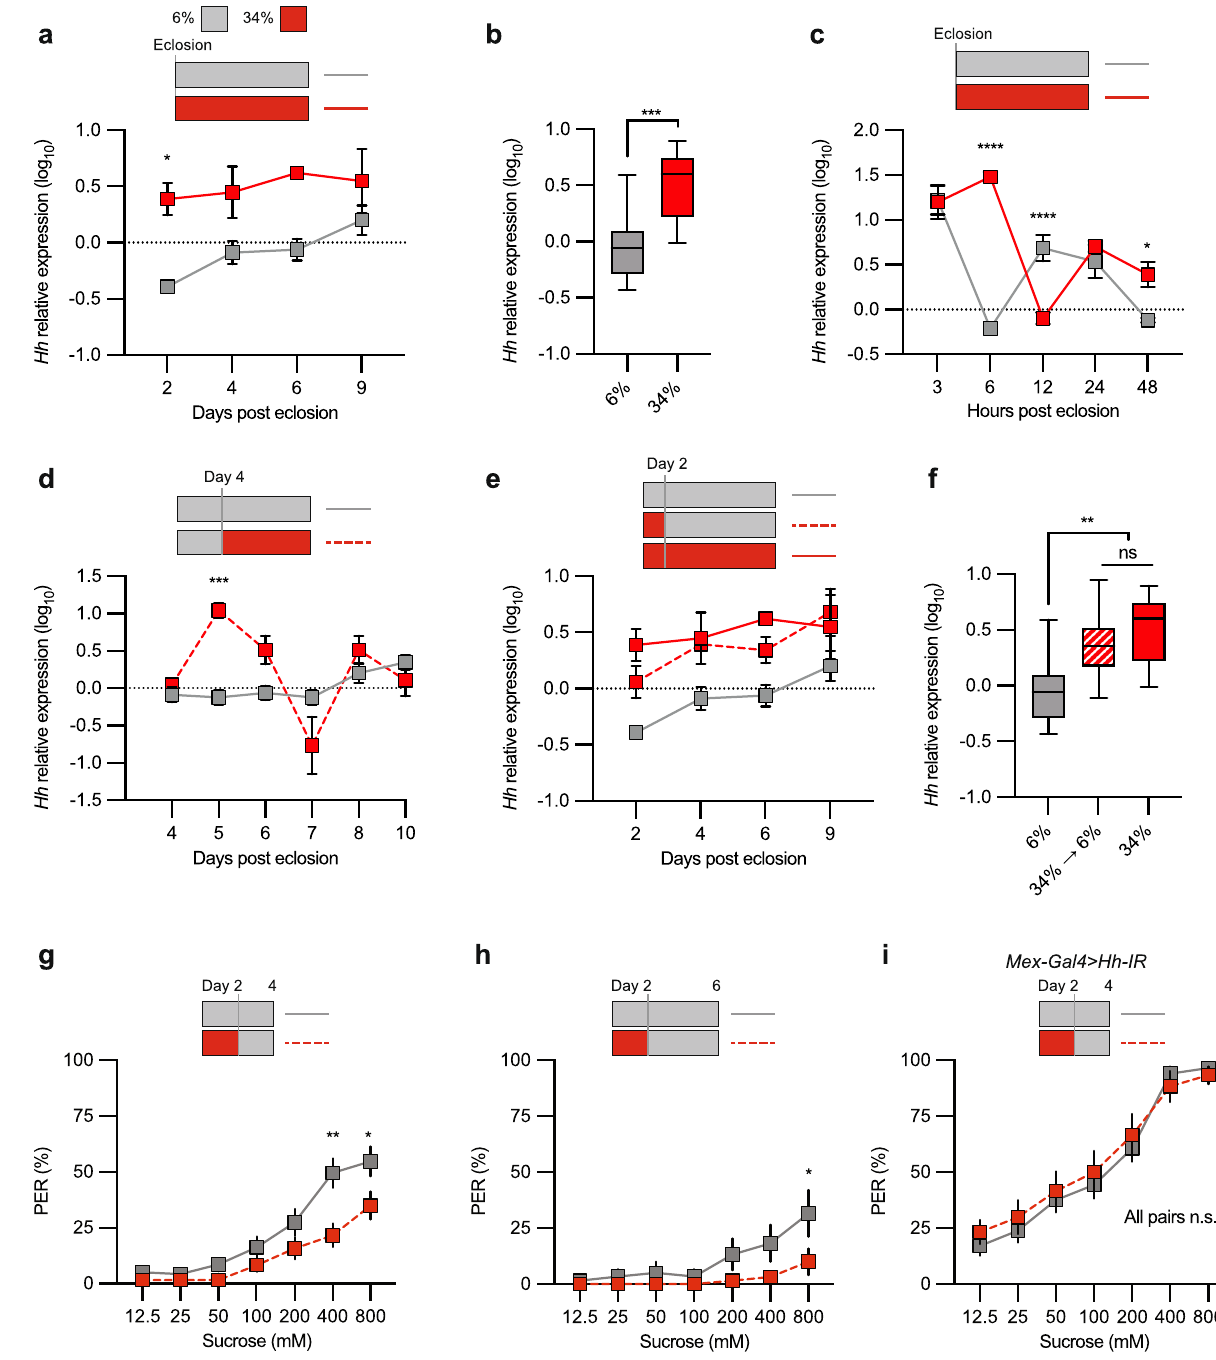
Fig. 3 | Regulation of gut Hh expression by dietary sugar. a Plot of a qPCR analysis w 1118 control fl ies Hh gut expression after a shift to either 6% or 34% sugar diet after eclosion. b A box plot showing the total Hh gut expression during the days 2 – 9 in a. The middle line indicates the median, and the whiskers indicate minimum and maximum values. c 6% or 34% sugar diets in fl uence on gut Hh expression during the fi rst 48hours post eclosion. d midgut Hh expression in fl ies onthe6%sugardietfor4daysandthenshiftedto6%or34%sugardiets.( e )Midgut Hh expression in fl ies on 6% or 34% sugar diets for 2 days and shifted to 6% or 34% sugardiets. f Aboxplotshowingthetotalgut Hh expressionduringthedays2 – 9for each diet in e. The middle line indicates the median, and the whiskers indicate